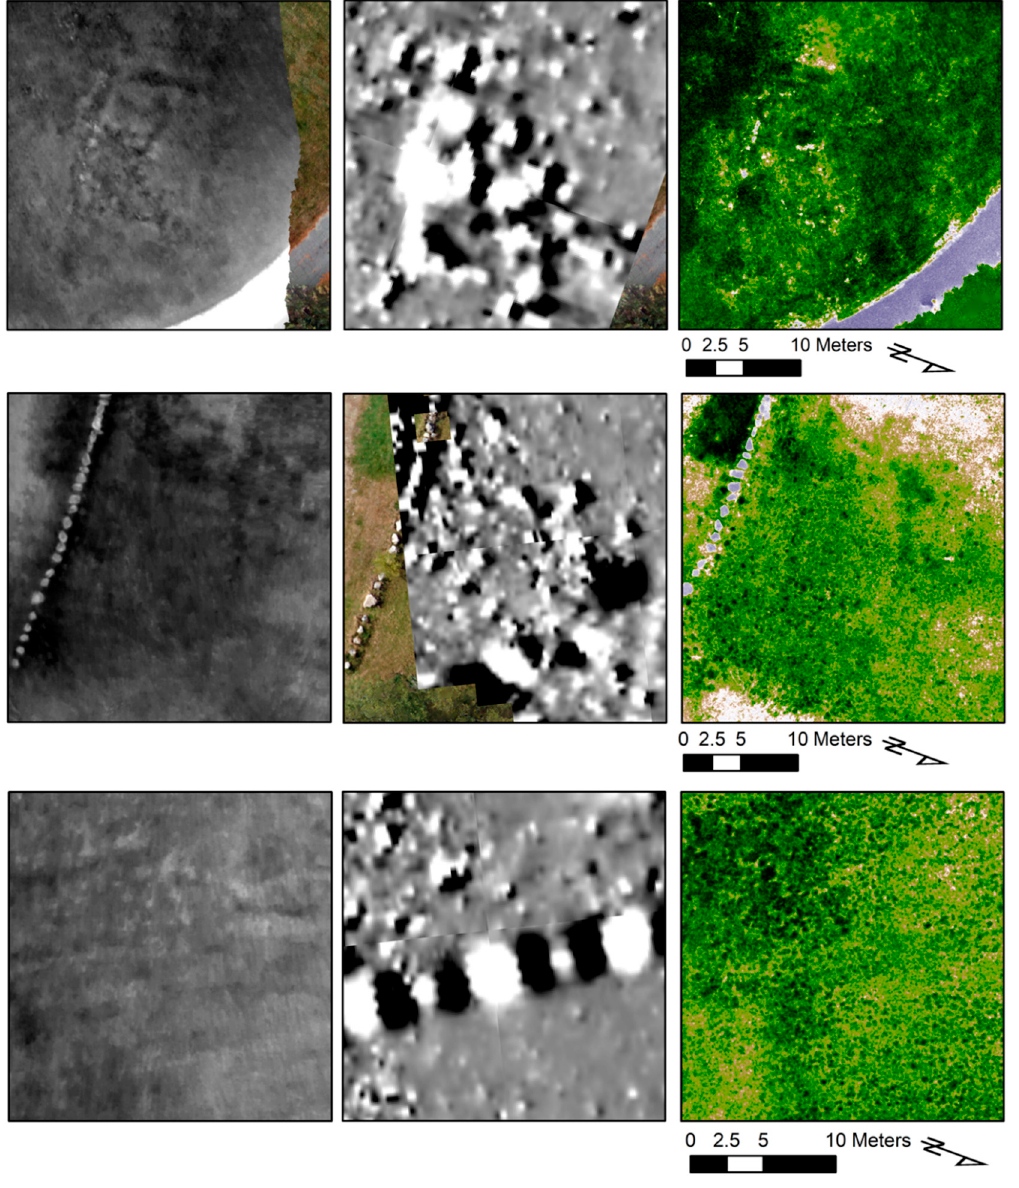
Figure 12. Detail comparison of thermal, magnetic gradiometer, and NDVI results. Top Row : (left) thermal image recorded 12 May 2017, (center) gradiometer data from 23 October 2017, (right) NDVI from 11 May 2017. Center Row : (left) thermal image recorded 12 May 2017, (center) gradiometer data recorded 23 October 2017, (right) NDVI recorded 11 May 2017. Bottom Row : (left) thermal image recorded 12 May 2017, (center) gradiometer data from 23 October 2017, (right) NDVI from 11 May 2017.